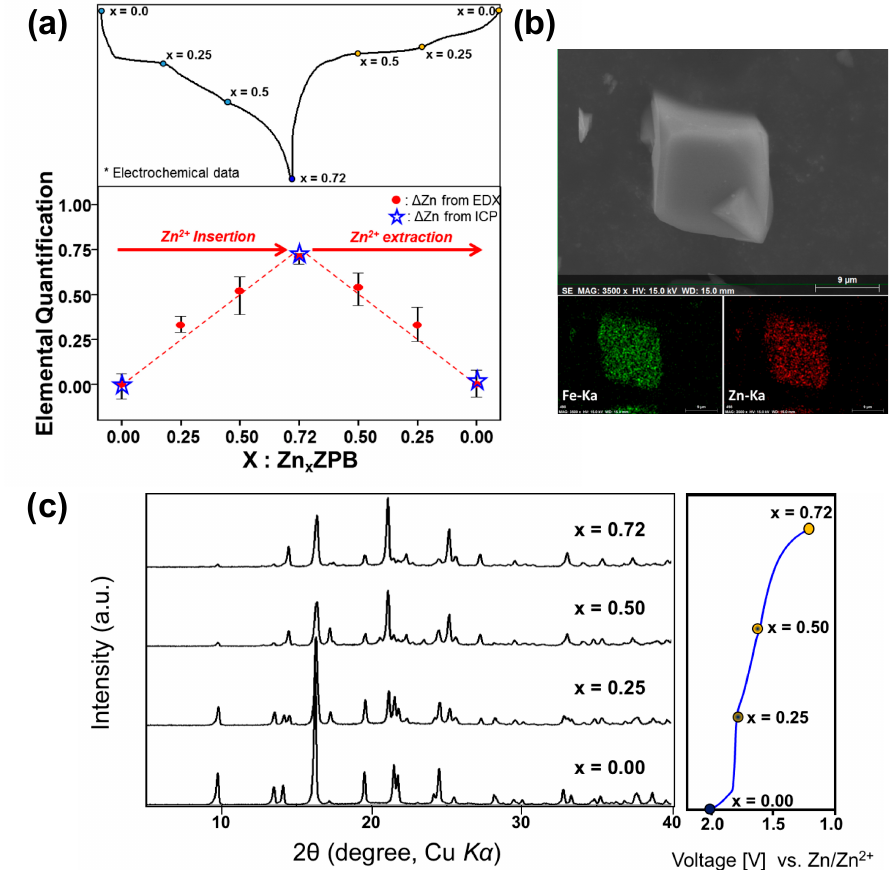
Figure 4. ( a ) Zn atomic ratios for Zn x ZPB electrode samples during a discharge-charge cycle, where the x values were estimated from ICP and FE-SEM EDX elemental analyses; ( b ) EDX elemental mapping of Zn 0.72 ZPB; ( c ) XRD patterns of Zn x ZPB ( x = 0, 0.25, 0.50, and 0.72) during discharging.